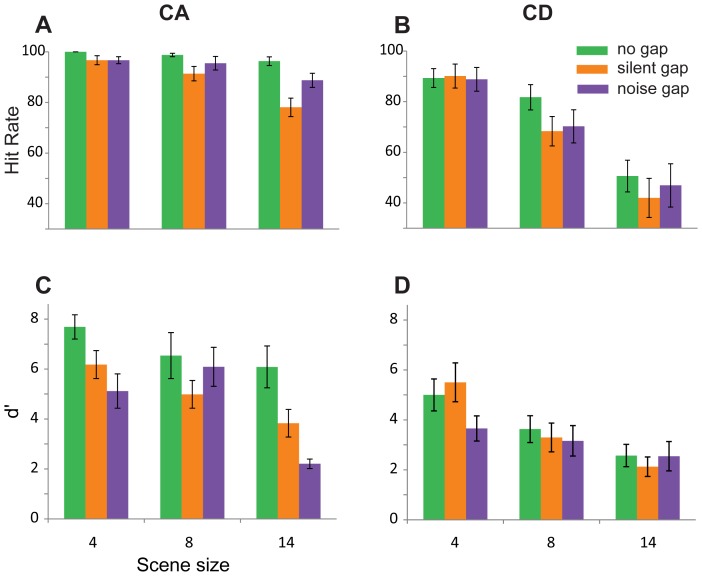
Results of Experiment 6 presented in a form that is relevant for interpreting the interaction of change type (CA vs. CD) and gap (continuous, vs. silence gap, vs. noise gap).The introduction of gaps adversely affected performance on CA but not CD changes. Error bars are 1 SE.